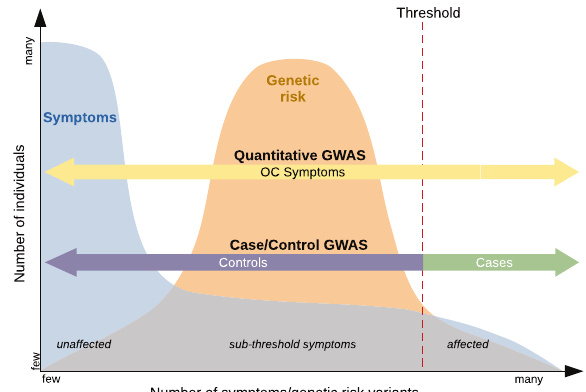
Fig. 1 Liability threshold model. In orange the distribution of genetic-risk variants for OCD in the population from few to many. In blue the distribution of OC symptoms in the population. The red dashed line depicts the diagnostic threshold. In a case/control GWAS (diagnostic framework) all individuals to the left (purple arrow) of the threshold would be considered a control, while all individuals to the right (green arrow), with a clinical diagnosis of OCD, would be considered a case. In a quantitative GWAS (dimensional framework) all individuals across the symptom- and genetic-risk-spectrum (yellow arrow) would be included, also weighting in subthreshold